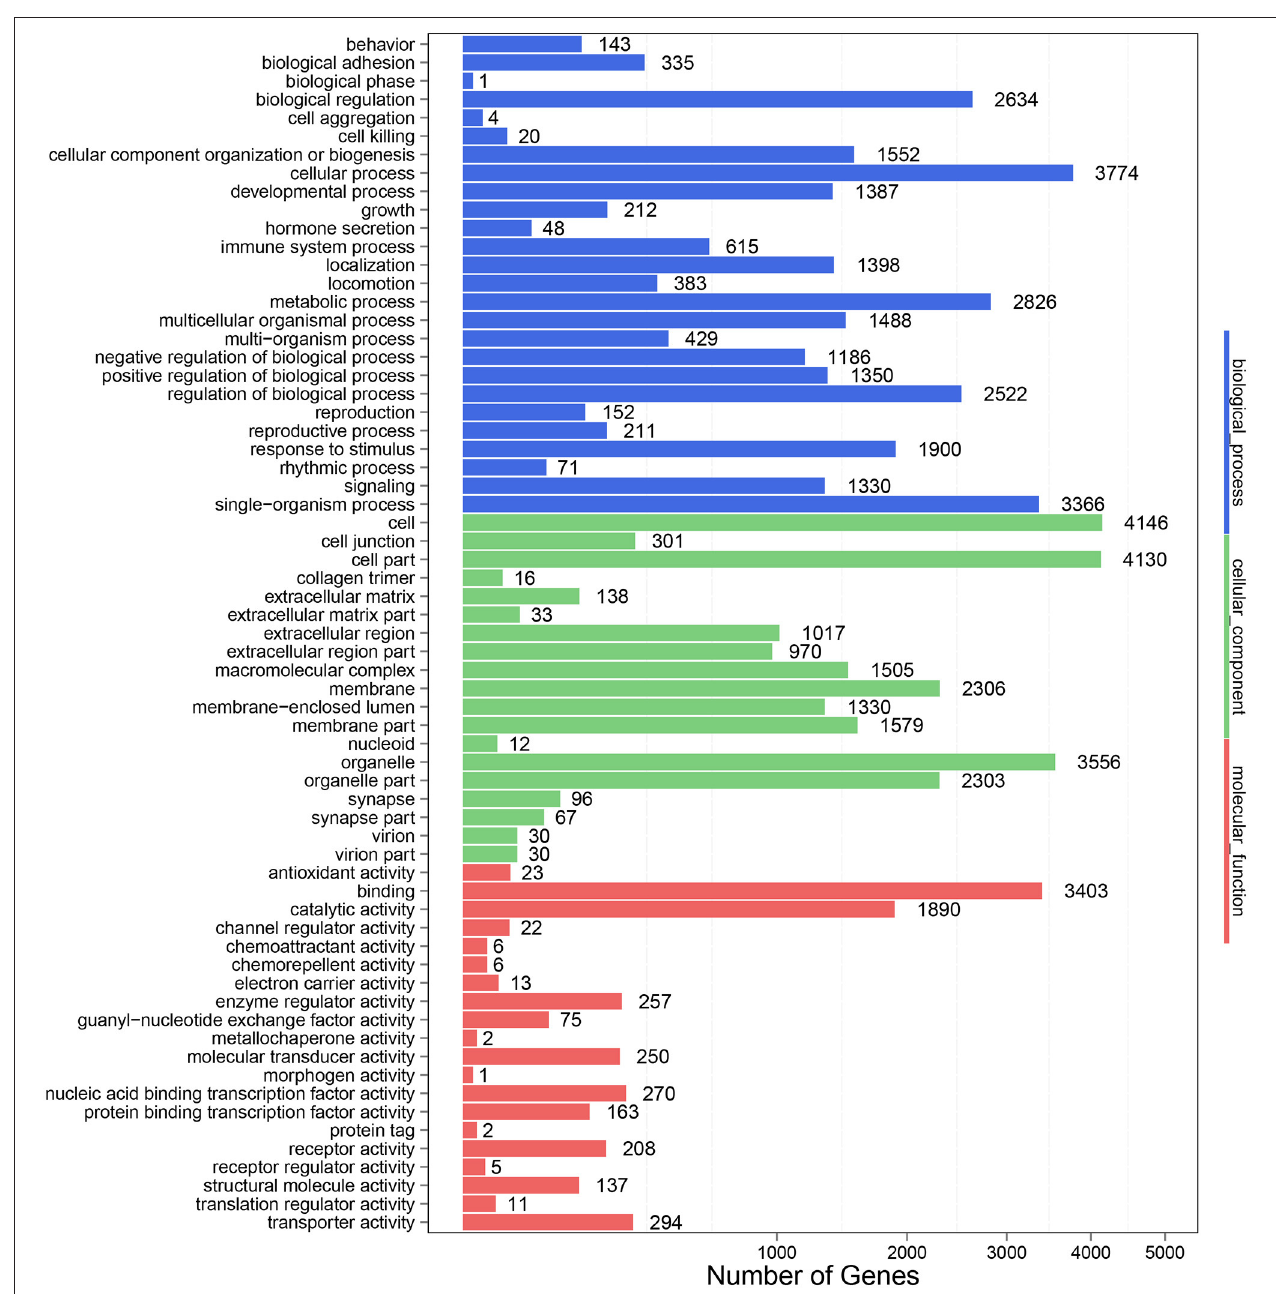
FIGURE 4 | GO functional classification of DE-miRNA target genes in response to P. multocida insults. The number of DEGs is shown on the X axis, while GO terms are shown on the Y axis. All GO terms are grouped into three ontologies: biological processes are shown in blue, cellular components in green, and molecular functions in